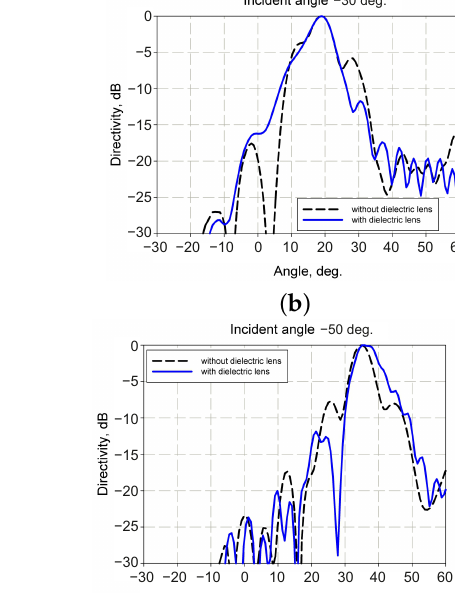
20 ( b ) 30 ( c ) 40 ( d ) 50 deg. for a 60GHz operating − − − −